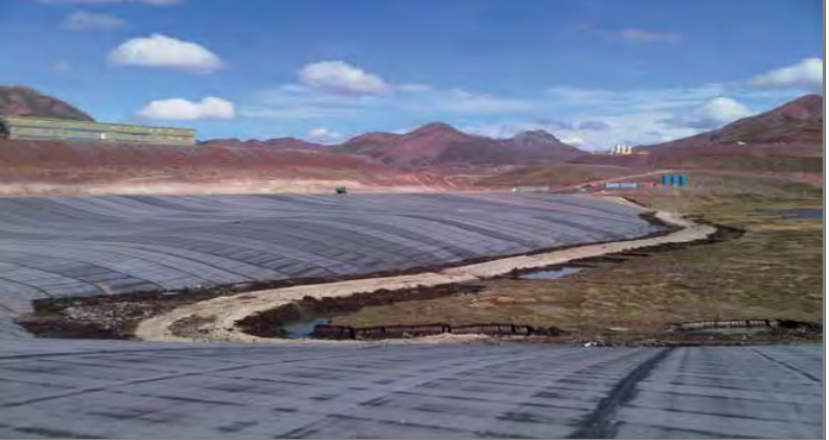
Figure 26. Mine waste rock dam upstream face waterproofing with bituminous geomembrane—TSF, Peru.